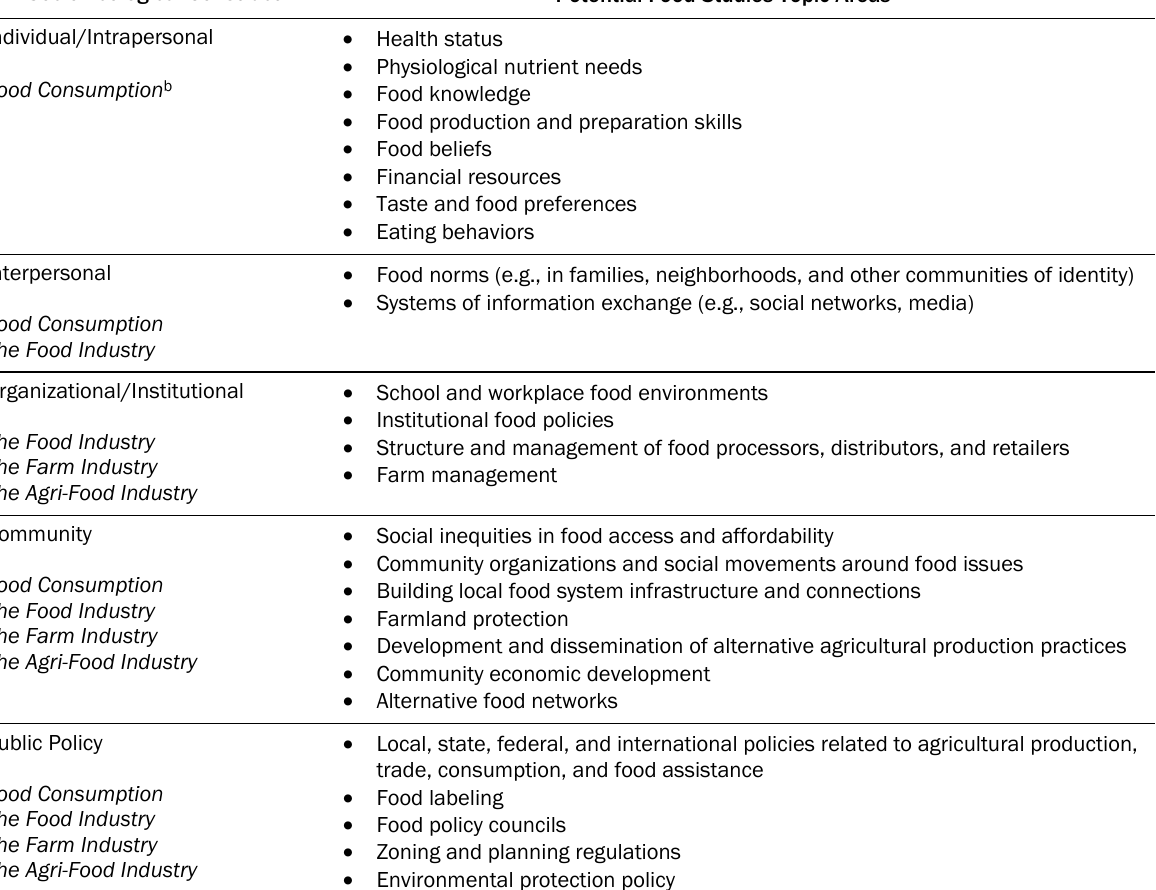
Table 1. Food Studies Viewed Through the Socio-Ecological Model Socio-Ecological Construct Potential Food Studies Topic Areas